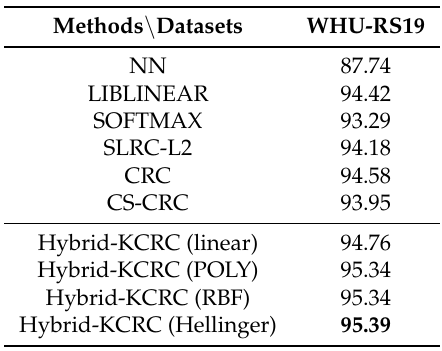
Table 4. Comparison with several classical classification methods on the WHU-RS19 dataset (%).